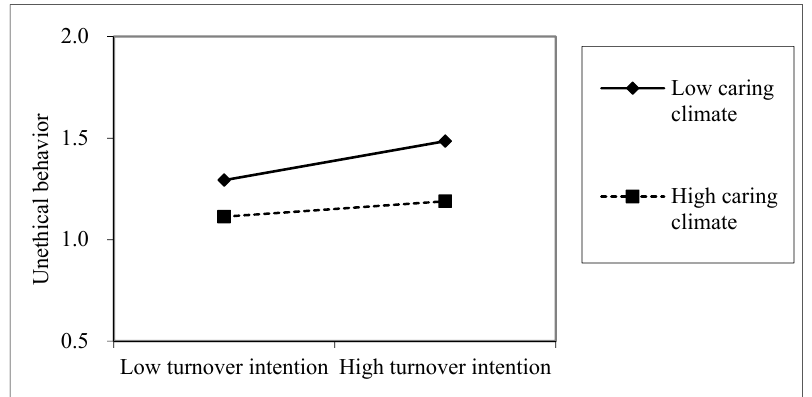
Figure 2. Interaction between turnover intentions and caring climate with regard to unethical behavior.